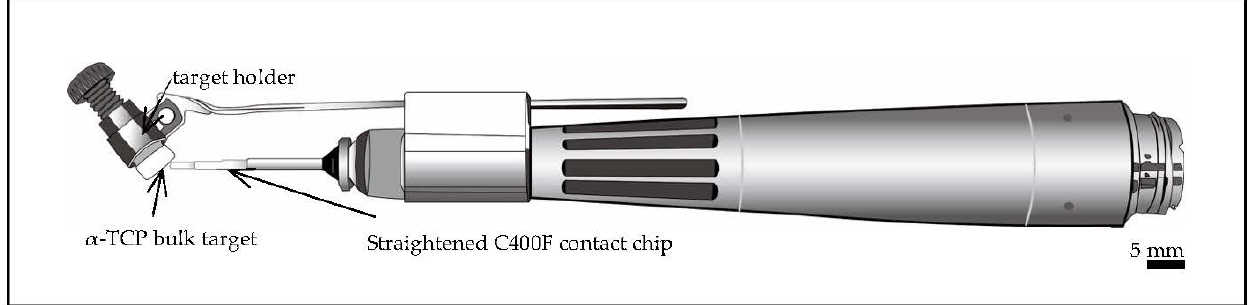
Figure 1. The schematic graph of handpiece consisting of a straightened C400F contact tip and α‐ TCP bulk target.